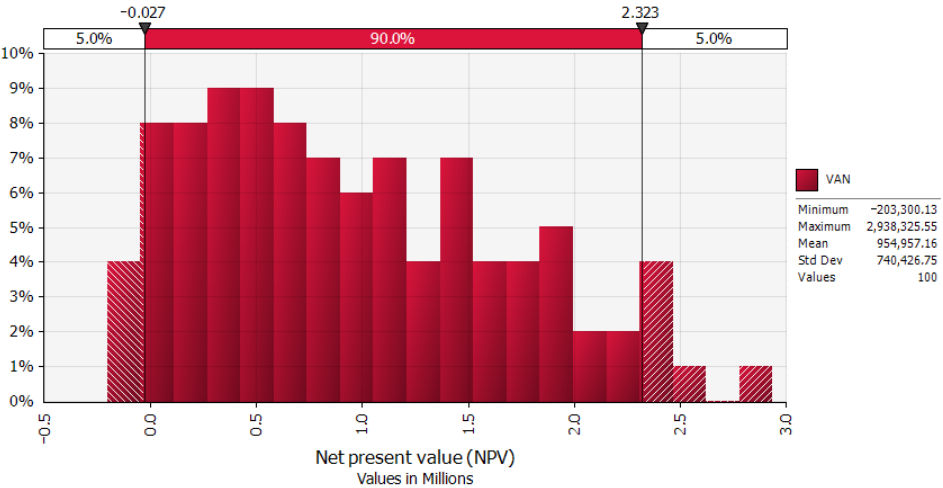
Figure 5. Results of the uncertainty analysis with values in kM$.